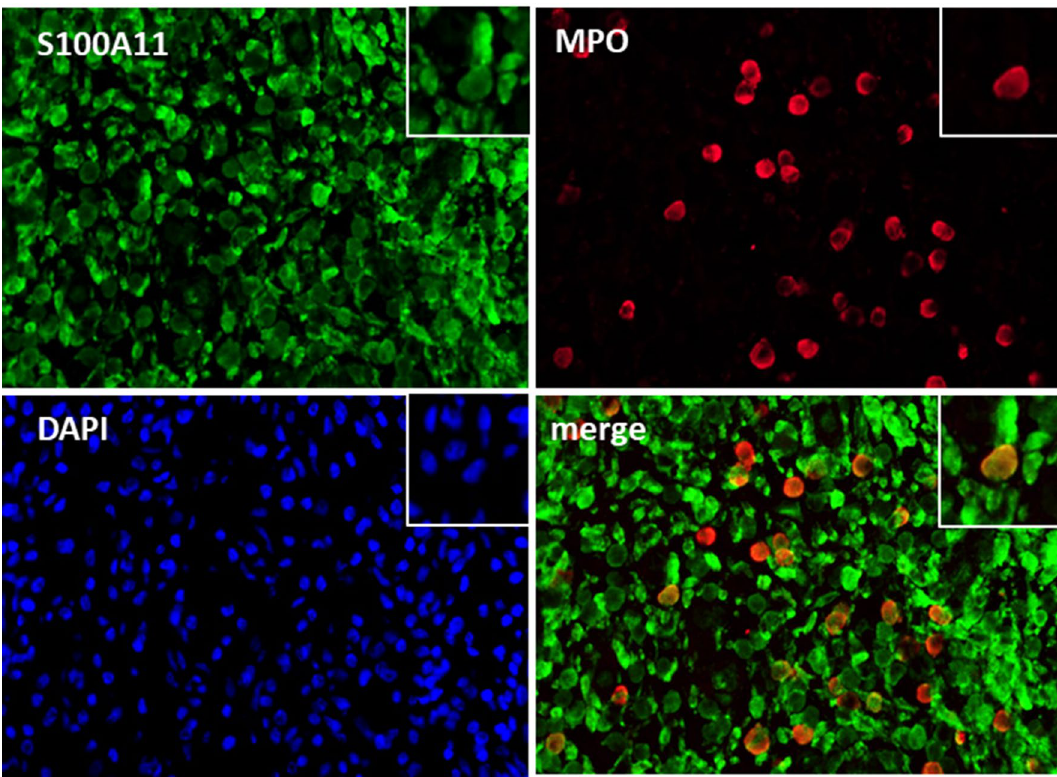
Figure 1. S100A11 is expressed by infiltrating neutrophils in synovial tissue from RA patients. Double immunofluorescence staining shows the co-localization of S100A11 (green) and myeloperoxidase (MPO) (red). Cells were visualized using an Olympus BX53 microscope with Olympus cellSens Standard imaging software V1.18. (https ://www.olymp us-lifes cienc e.com/en/softw are/cells ens/). Representative images are shown at ×400 magnification, and cellular details are shown at 1000x (A) (n =